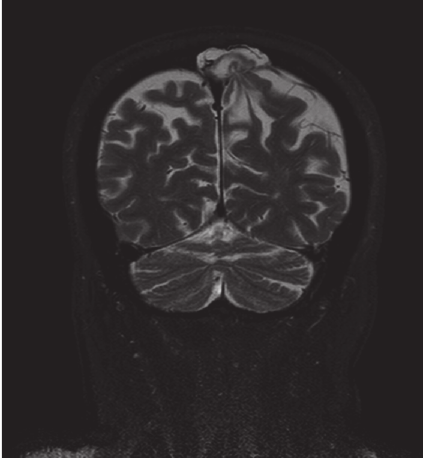
Figure 4: Axial T2-weighted FLAIR image shows hyperintensity of the brain herniation, probably due to prior